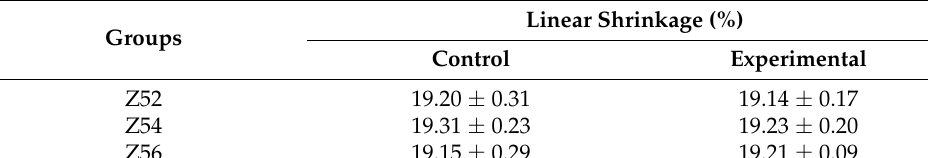
Table 2. Average linear shrinkage of printed zirconia sample.